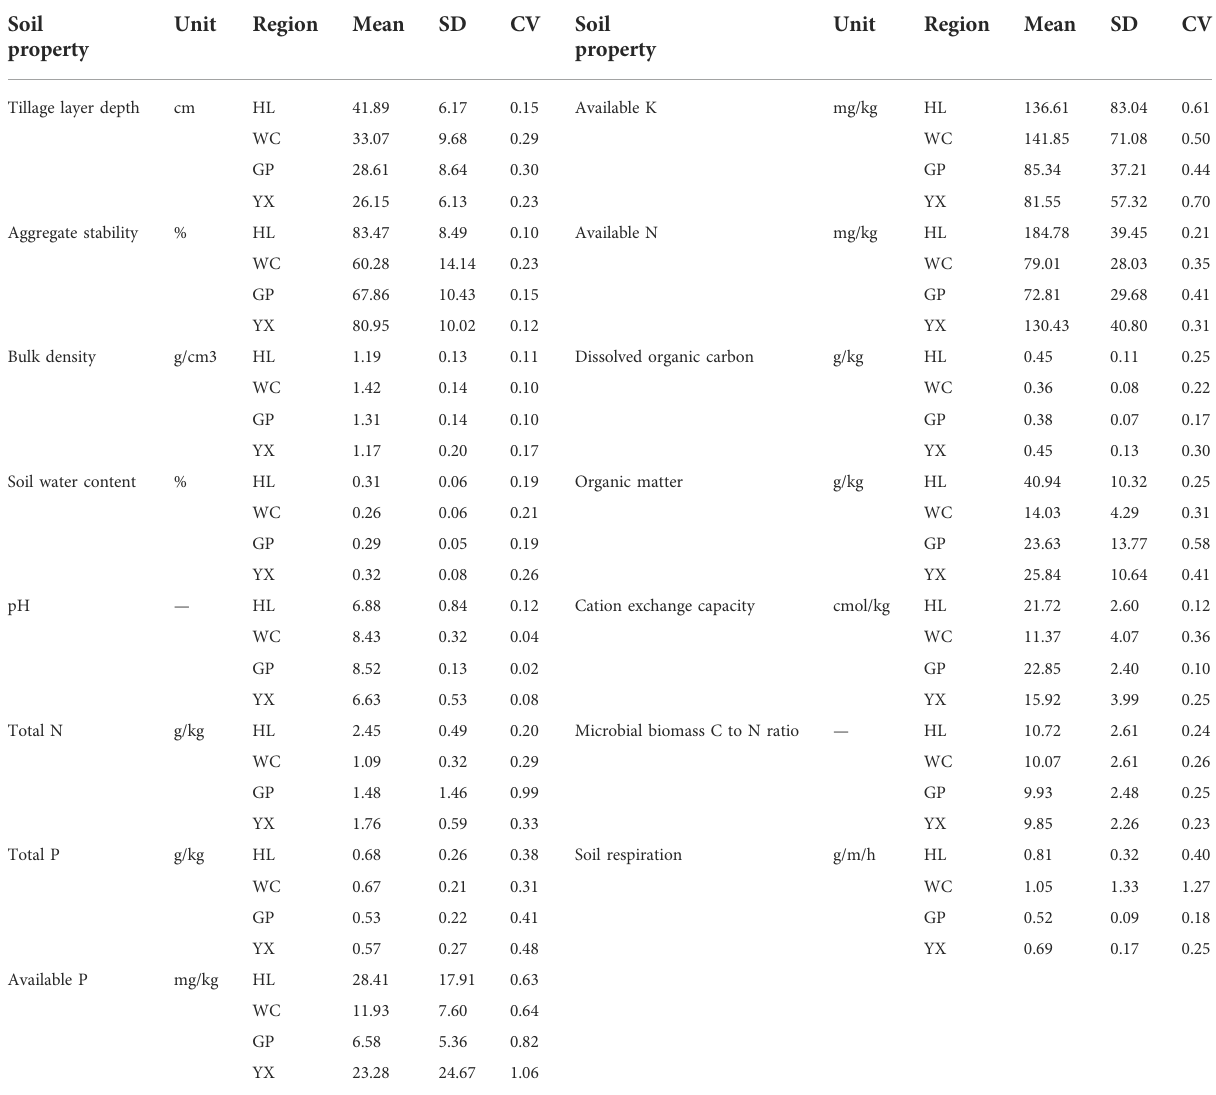
TABLE 3 Descriptive statistics of the soil properties in different regions. Soil